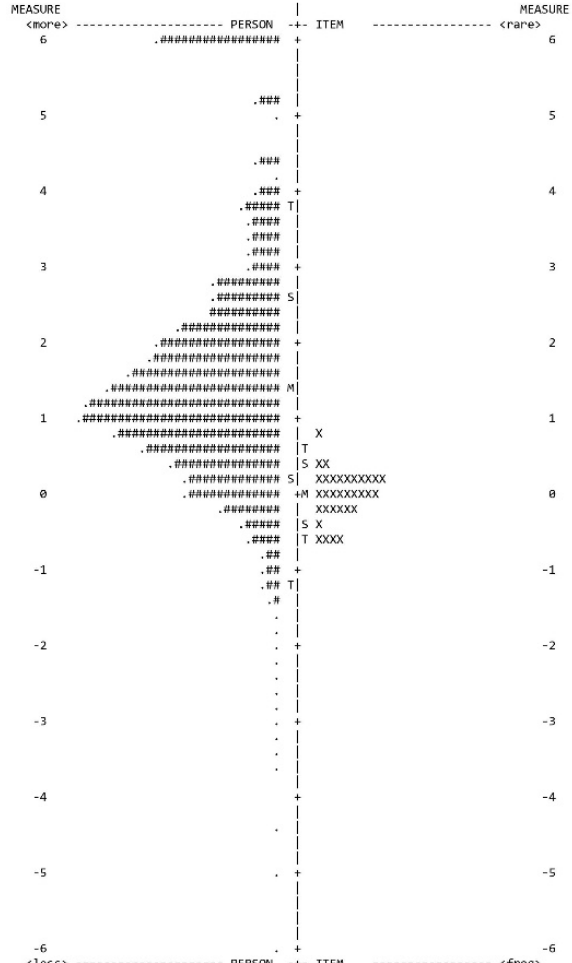
Figure 1. Wright map for the HELIA. RE = reading; ATL = access to information; UND = understand- ing; APP = appraisal; DM = decision making/behavioral intention. Each # indicates 61